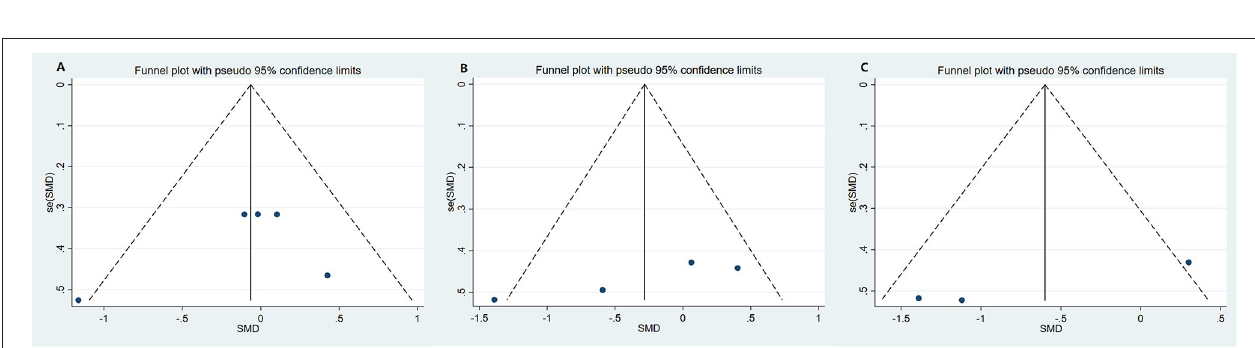
FIGURE 13 | Funnel plot for publication bias of study. (A) Funnel plot for publication bias of the effect of microbiota-driven therapy on circulating choline level; (B) Funnel plot for publication bias of the effect of microbiota-driven therapy on circulating betaine aldehyde level; (C) Funnel plot for publication bias of the effect of microbiota-driven therapy on circulating L-carnitine